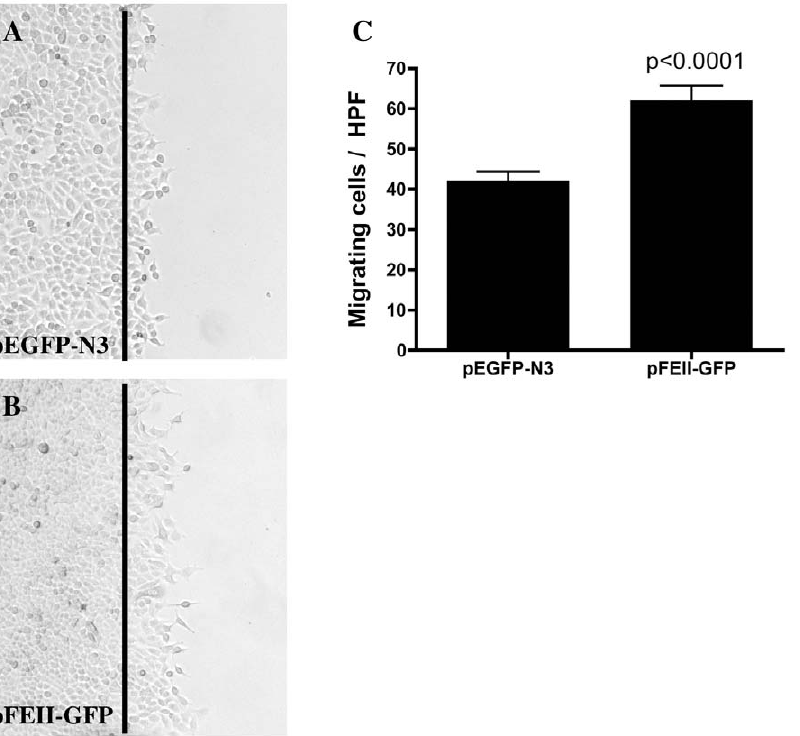
Figure 2. Overexpression of EMAP II increases cell migration. Confluent cells were wounded using a rubber policeman, wounding site marked, and examined for migration 15 hours post wounding. The black line represents the wounded margin. Cells overexpressing pFEII-GFP (B,C) had a marked increase in migration as compared empty vector control (pEGFP-N3, A,C) (p , 0.0001) (n=9 in triplicate performed on 3 different occasions).